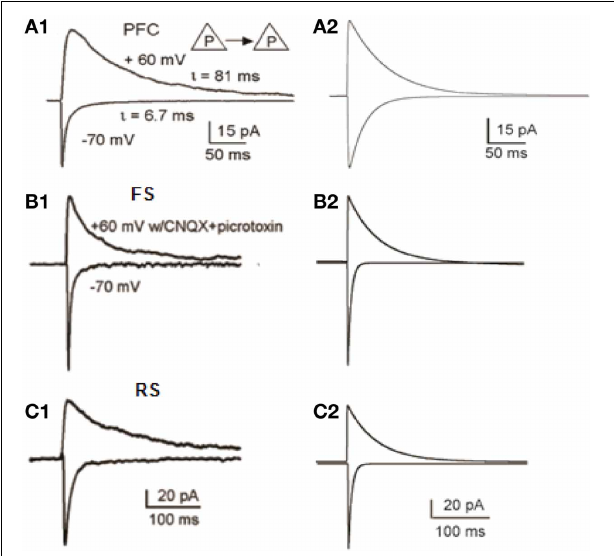
FIGURE 3 | Validation of Synaptic Properties within the microcircuit. (A1) Current responses from a layer 5 pyramidal-to-pyramidal pair. When membrane potentials were held at − 70mV, the currents are predominantly mediated by AMPA receptors; whereas at + 60mV, the currents were largely mediated by NMDA receptors (adapted from Wang et al., 2008, Copyright 2008 National Academy of Sciences, USA). (A2)